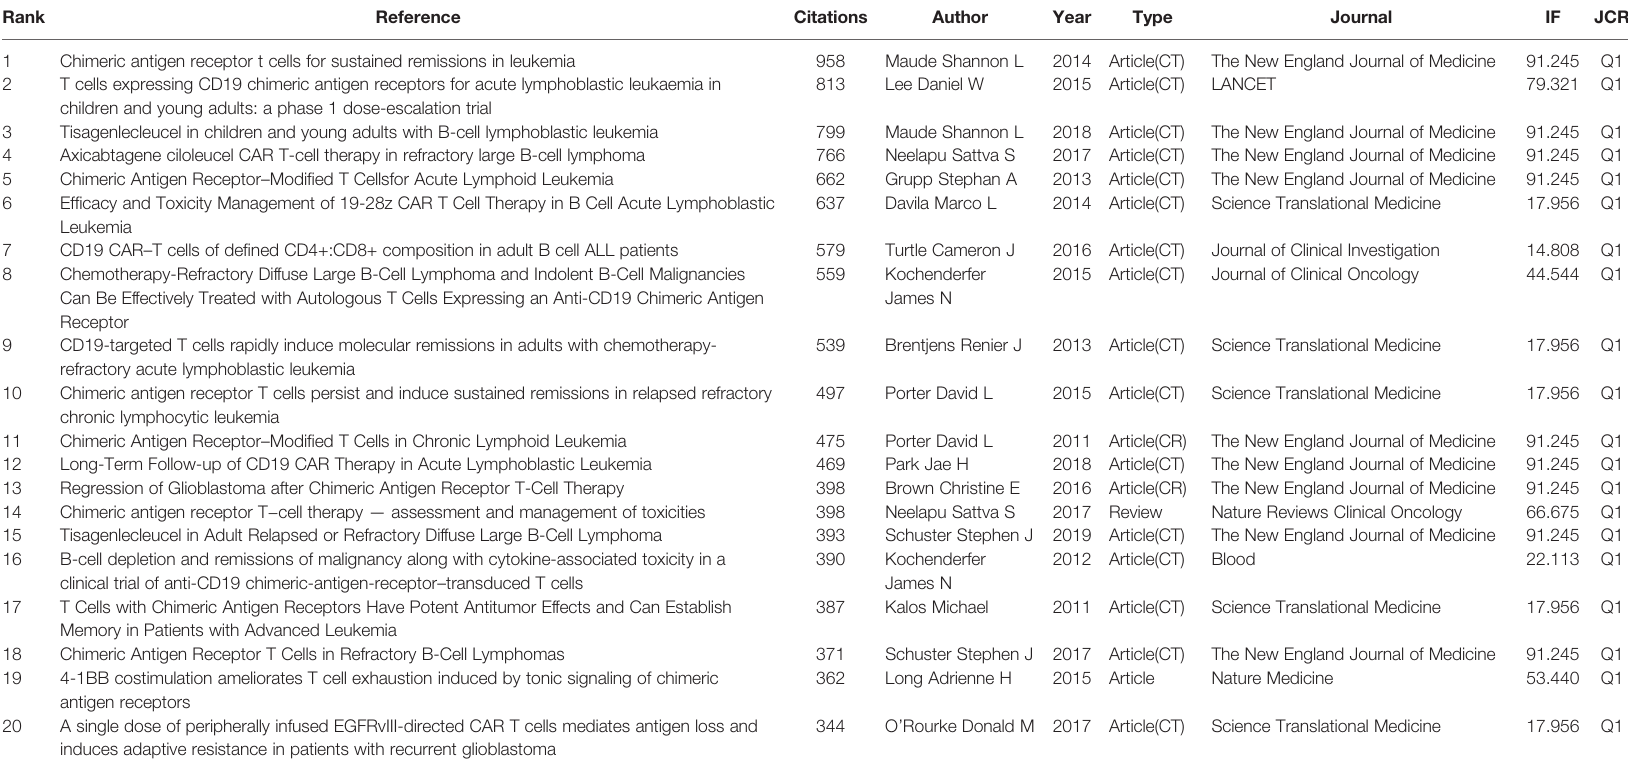
TABLE 4 | Top 20 co-cited references related to CAR-based